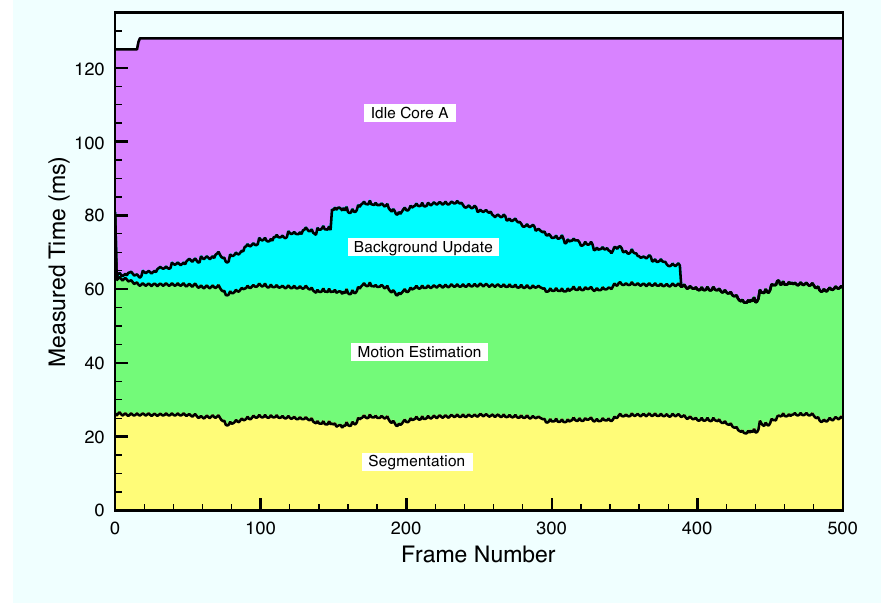
Figure 11. Measured times of each phase of video processing running in Core A, including the idle time. The data are represented stacked. The different areas are labeled with the corresponding phase of